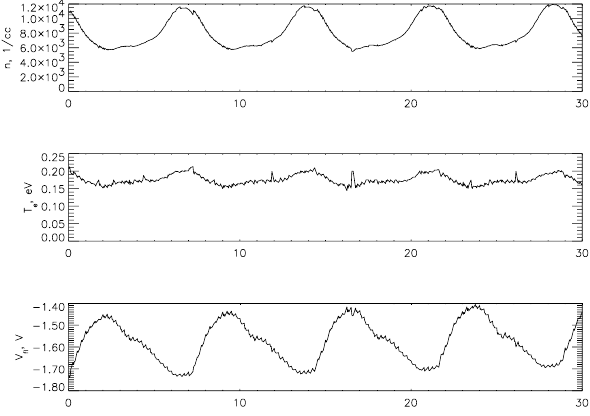
Fig. 12. Plasma parameters derived from the fits to the EMMA current sweeps for Case 2. The format is the same as in Fig. 7.